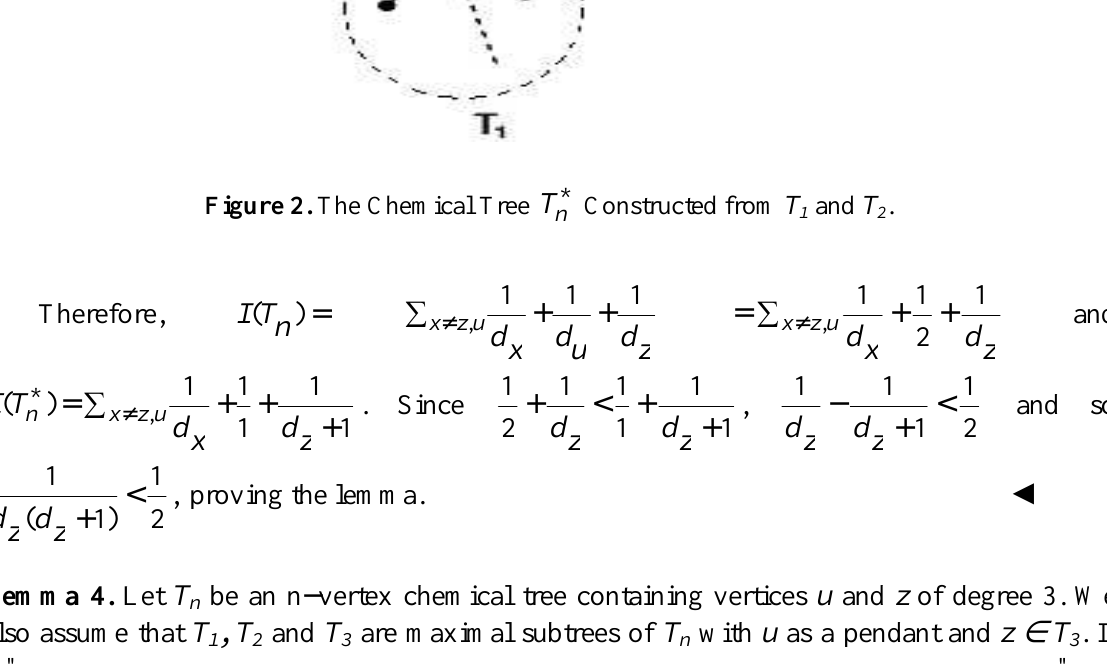
Figure 2. The Chemical Tree